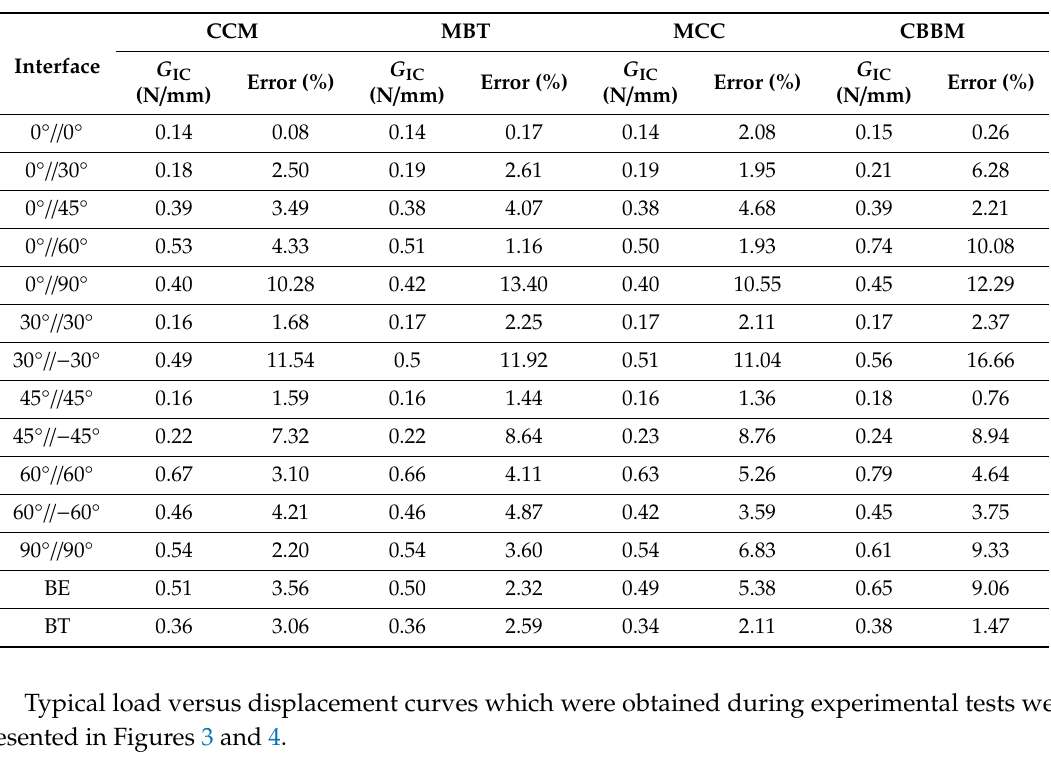
Table 5. Critical strain energy release rate (c-SERR) obtained for di ff erent DCB specimens by using di ff erent calculation methods (average values and standard deviations).